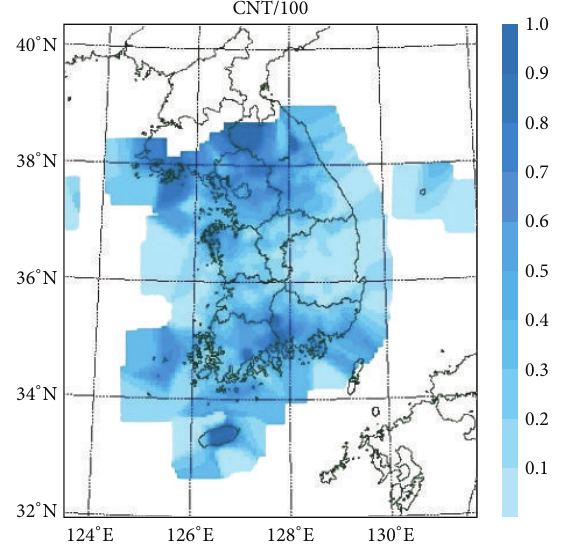
Figure 11: The distribution of heavy rainfall for the whole seasons